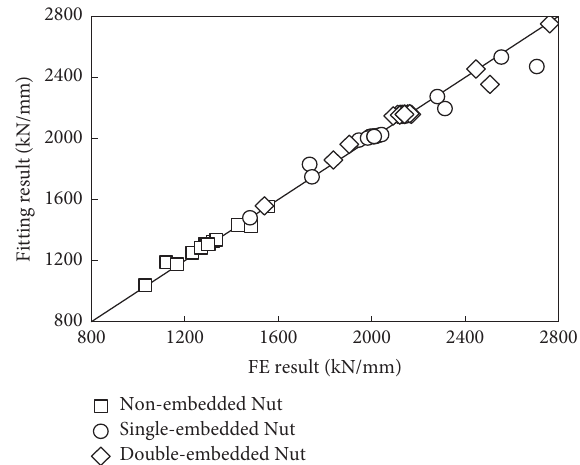
Figure 8: Comparisons of tension stiffness between the FE results and fitting results.